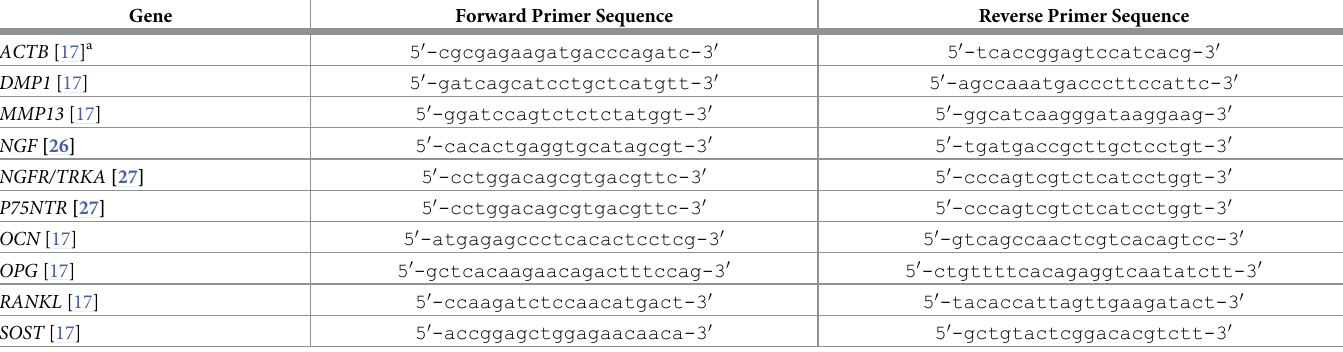
Table 1. Human mRNA-specific oligonucleotide primer sequences.